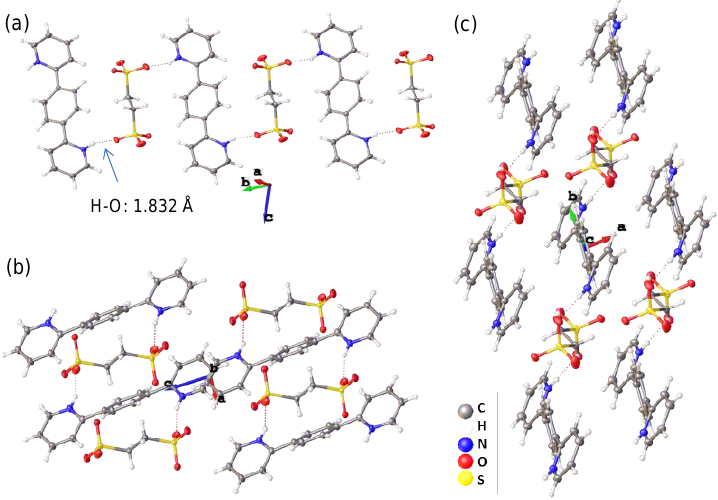
Figure 2. Molecular packing of the single crystal of 4 viewed from the ( a ) a , ( b ) b , and ( c ) c axes.